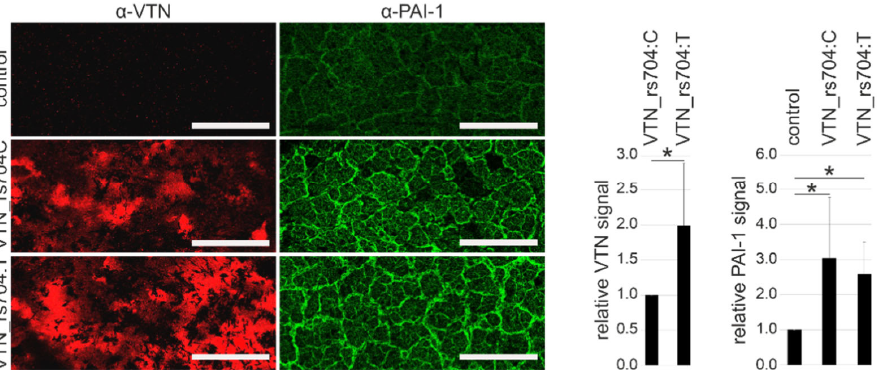
Figure 4. Effect of vitronectin isoforms on ECM deposition of PAI ‐ 1 by RPE ‐ derived cells. ARPE ‐ 19 cells transfected with expression vectors for VTN_rs704: C or VTN_rs704: T or an empty control vector (pcDNA3.1, control) were seeded onto transwell filter inserts. After 8 weeks, the inserts were decellularized and subjected to immunofluorescence staining with antibodies against vitronectin ( α‐ VTN) and PAI ‐ 1 ( α‐ PAI ‐ 1). Confocal microscopy images were taken at 10× magnification. Scale bars: 100 μ m. Data represent the mean ± SD of four independent replicates, calibrated against VTN_rs704: C (for vitronectin signals) or control (for PAI ‐ 1 signals). Asterisks indicate statistically significant differences (* p < 0.05, Mann–Whitney U test for VTN; * p < 0.05, Kruskal–Wallis test for PAI ‐ 1, followed by Dunn’s multiple comparison test with Bonferroni correction).